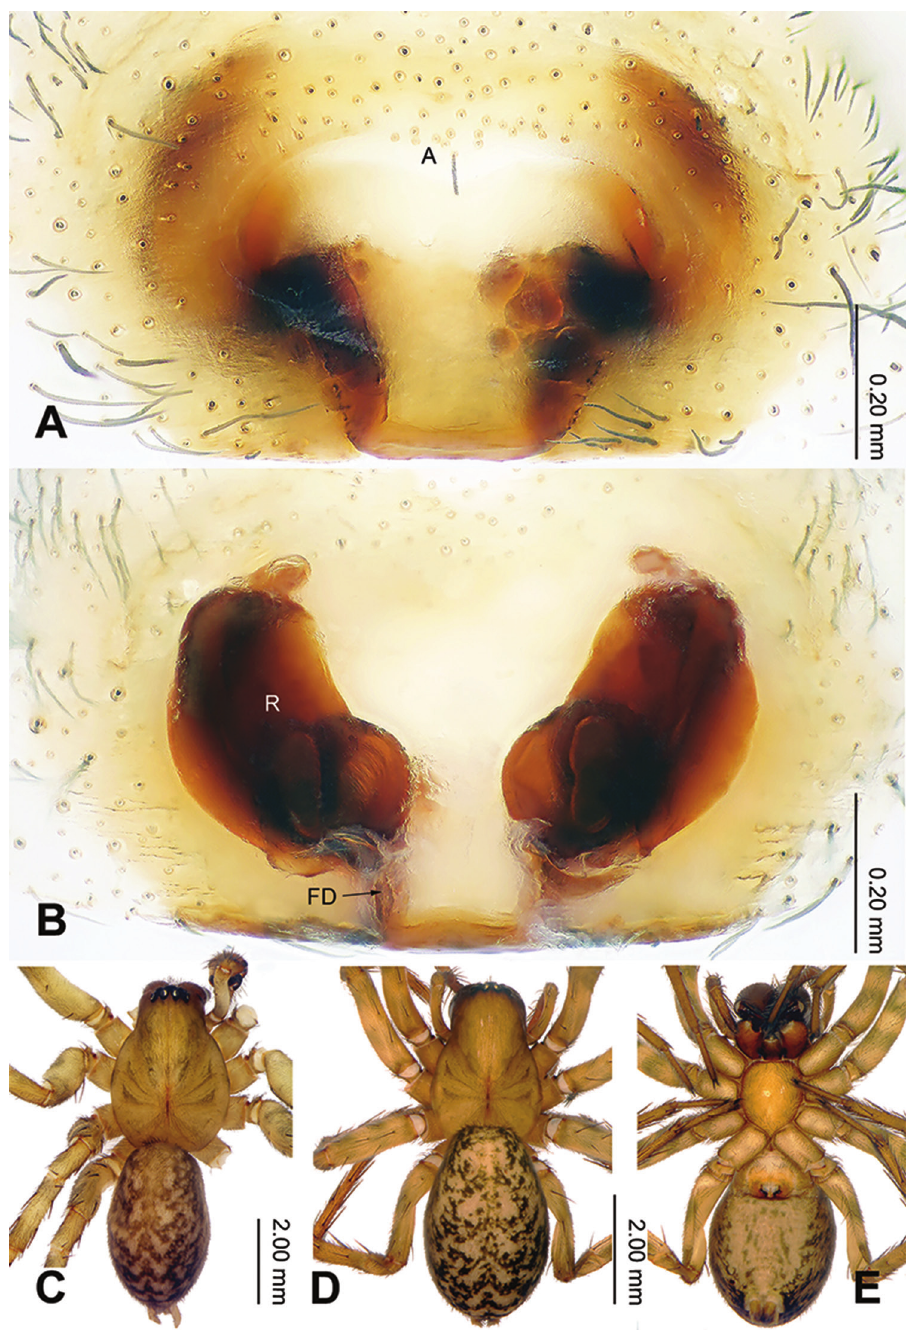
Figure 8. Epigyne and habitus of Sinodraconarius patellabifidus A Epigyne, ventral B Vulva, dorsal C Male habitus, dorsal D Female habitus, dorsal E Female habitus, ventral. Scale bar equal for D and E